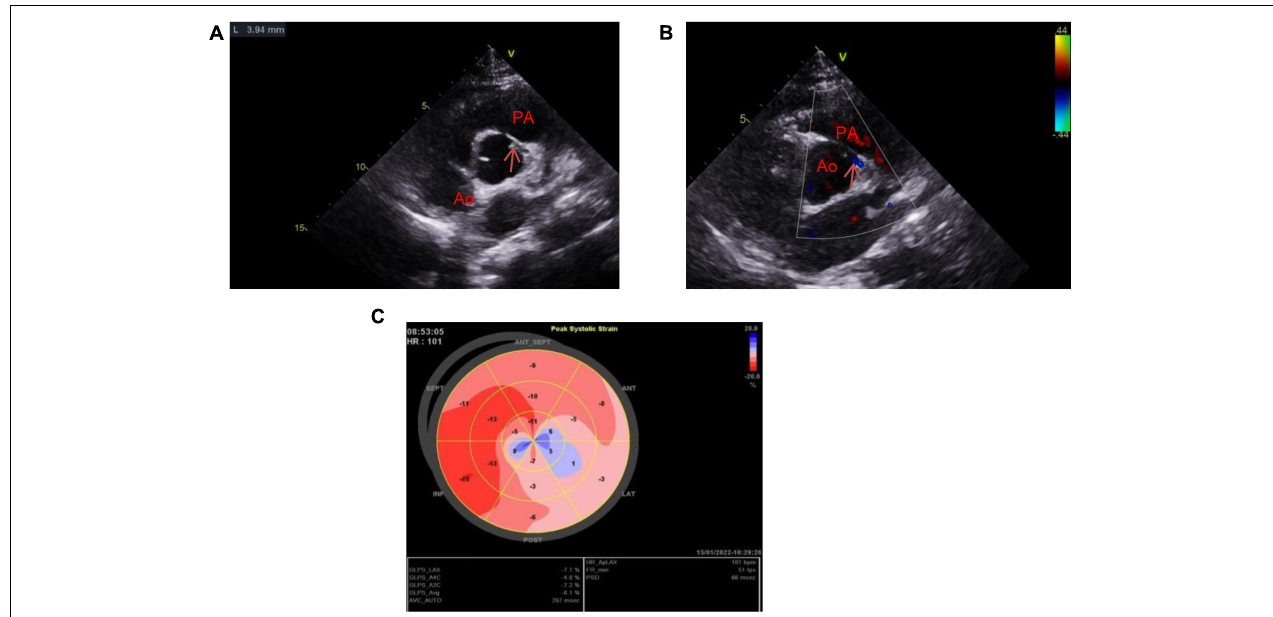
FIGURE 2 | Images of transthoracic echocardiography 1 month post-operatively illustrating staged ventricular wall motion hypokinesia (extensive anterior wall, left ventricular lateral wall, and apex) and LVEF, 40%. (A) After unroofing of the intramural portion, the diameter of the left coronary ostium is approximately 3.94 mm. (B) The LM blood flow is in normal velocity. (C) Ultrasound speckle tracking image shows GLS of the left ventricle,